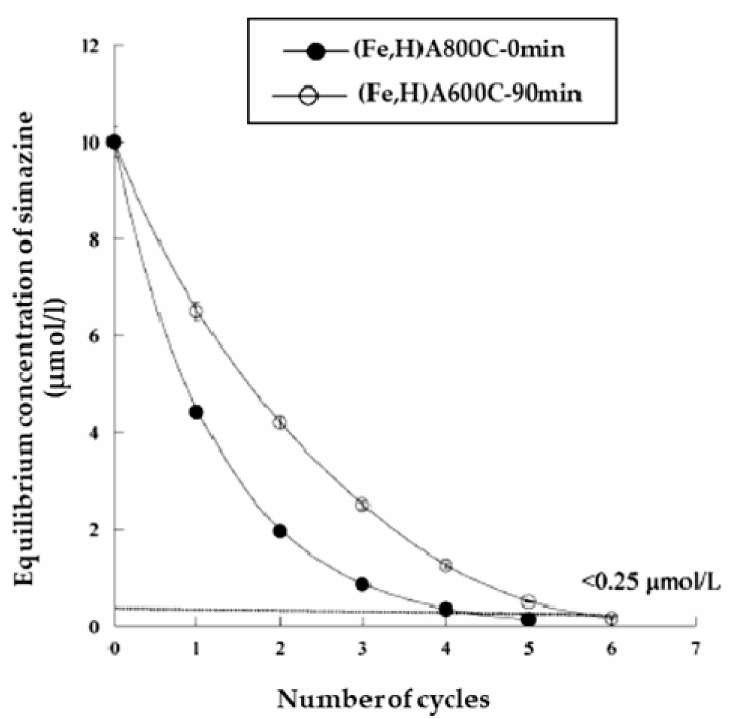
Figure 17. Iterative process of simazine removal from waters (s / l ratio = 1 / 1000, for 1.5 h, maximum adsorption pH). Reproduced with permission from Pansini et al., Journal of Environmental Chemical Engineering , published by Elsevier,